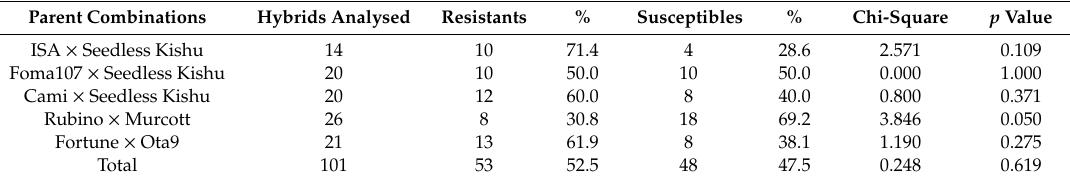
Figure 9. Leaves of resistant and susceptible mandarin hybrids showing a range of necrosis severity four days after inoculation with A. alternata spores. The leaves belong to hybrids of ISA × Seedless Kishu ( a , b ), Cami × Seedless Kishu ( c , d ), Fortune × OTA9 ( e , f ), Rubino × Murcott ( g , h ), and Foma107 × Seedless Kishu ( i , l ) populations. a, c, e, g, i: susceptible hybrids; b, d, f, h, l: resistant hybrids. Table 5. In vitro phenotyping of hybrid populations for Alternaria brown spot resistance.